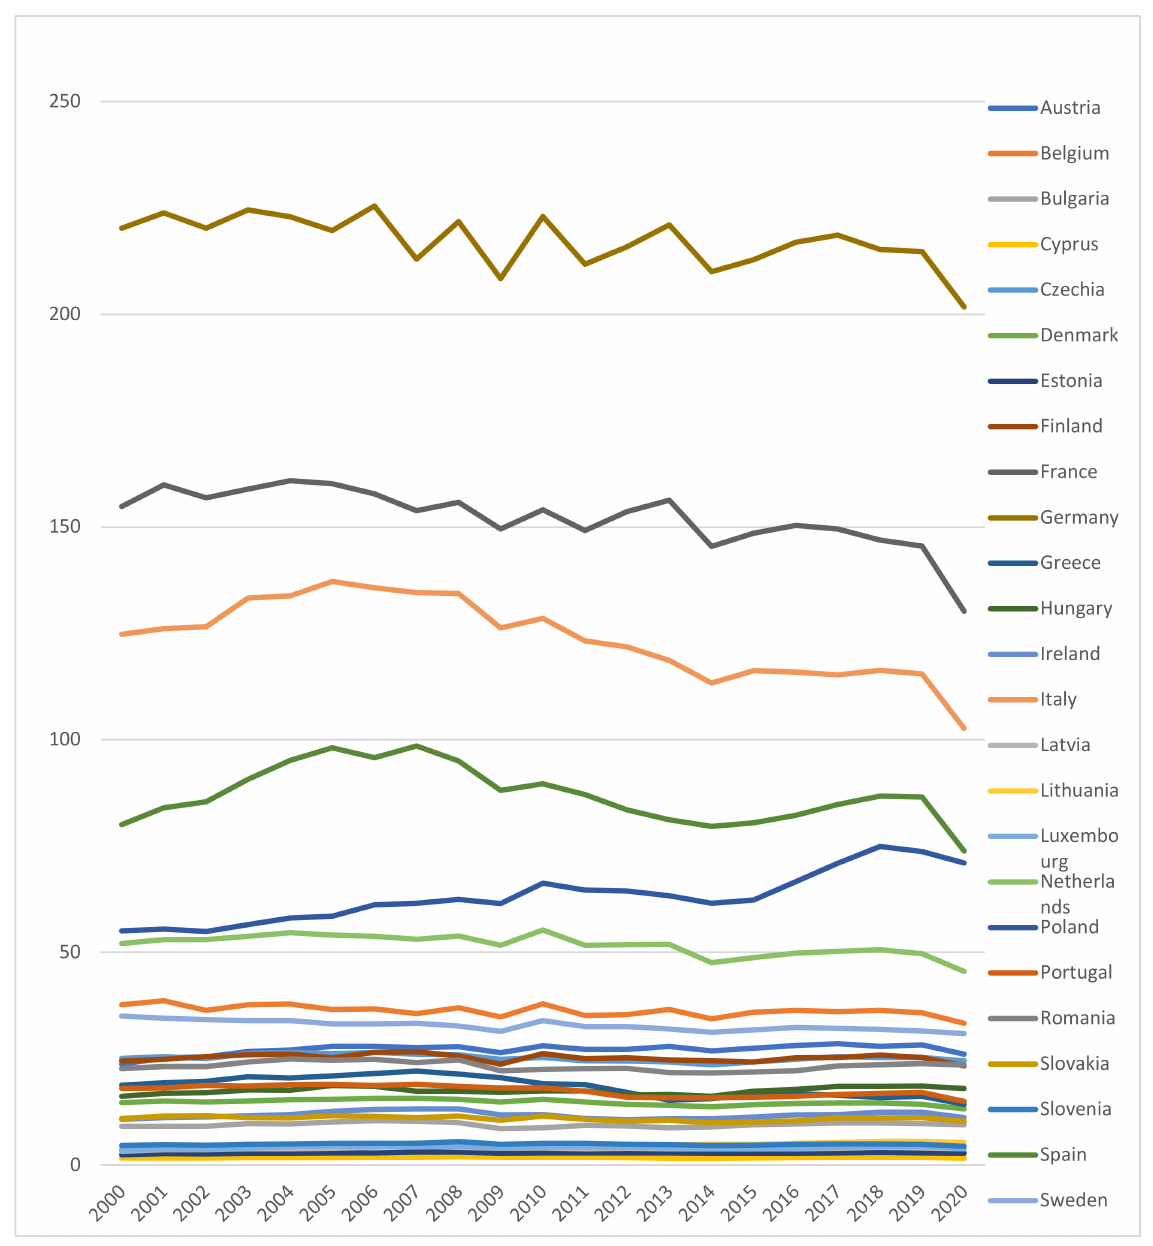
Figure 5. Evolution of energy consumption for 25 EU countries during